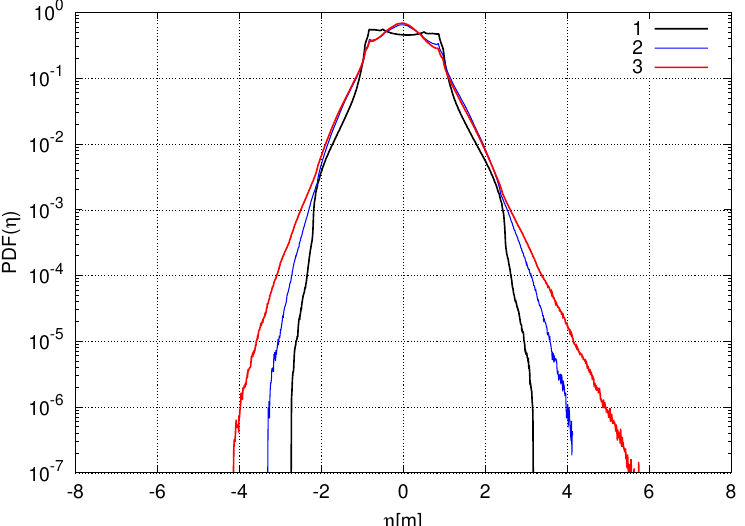
Figure 10. Probability density functions of surface amplitude PDF ( η ) in logarithmic scale for three three different nonlinear models at µ = 0.04 and ˜ k p = 10. Black solid curve 1 corresponds to the NLSe model, blue solid curve 2—to the compact Dyachenko-Zakharov envelope equation and red solid curve 3—to the fully nonlinear